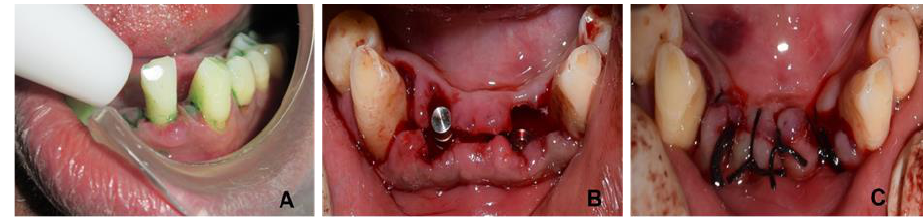
Figure 1. ( A ) Photodynamic therapy; ( B ) implants placed after extraction; ( C ) sutures